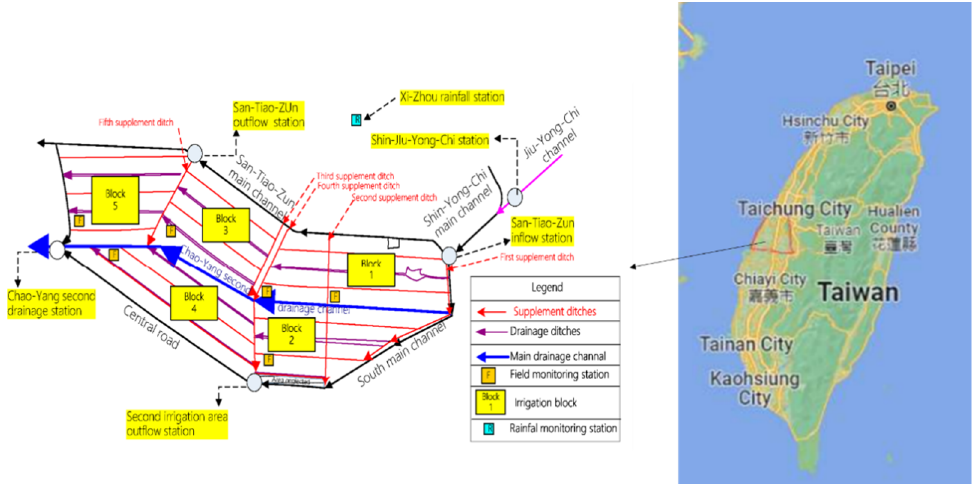
Figure 1. The layout of the experimental site.